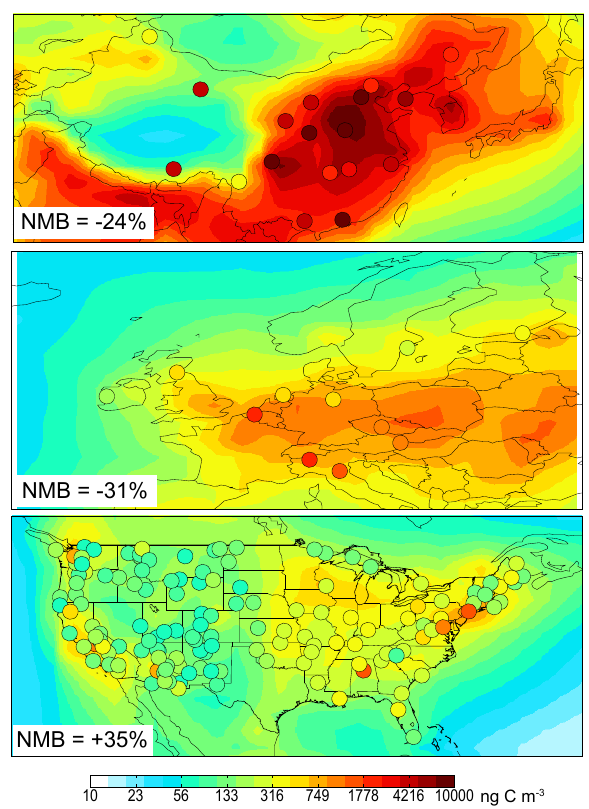
Fig. 3. Annual mean surface air concentrations of BC aerosol in China, Europe, and the US. Model results for 2008 (solid con- tours) are compared to observations (circles). Observations are from Zhang et al. (2008a) in China for 2006, from the EMEP network in Europe for 2002–2003 (http://tarantula.nilu.no/projects/ ccc/emepdata.html), and from the IMPROVE network in the US for 2008 (http://vista.cira.colostate.edu/improve/Data-/IMPROVE/ AsciiData.aspx). Normalized mean bias (NMB) statistics for each region are shown inset.